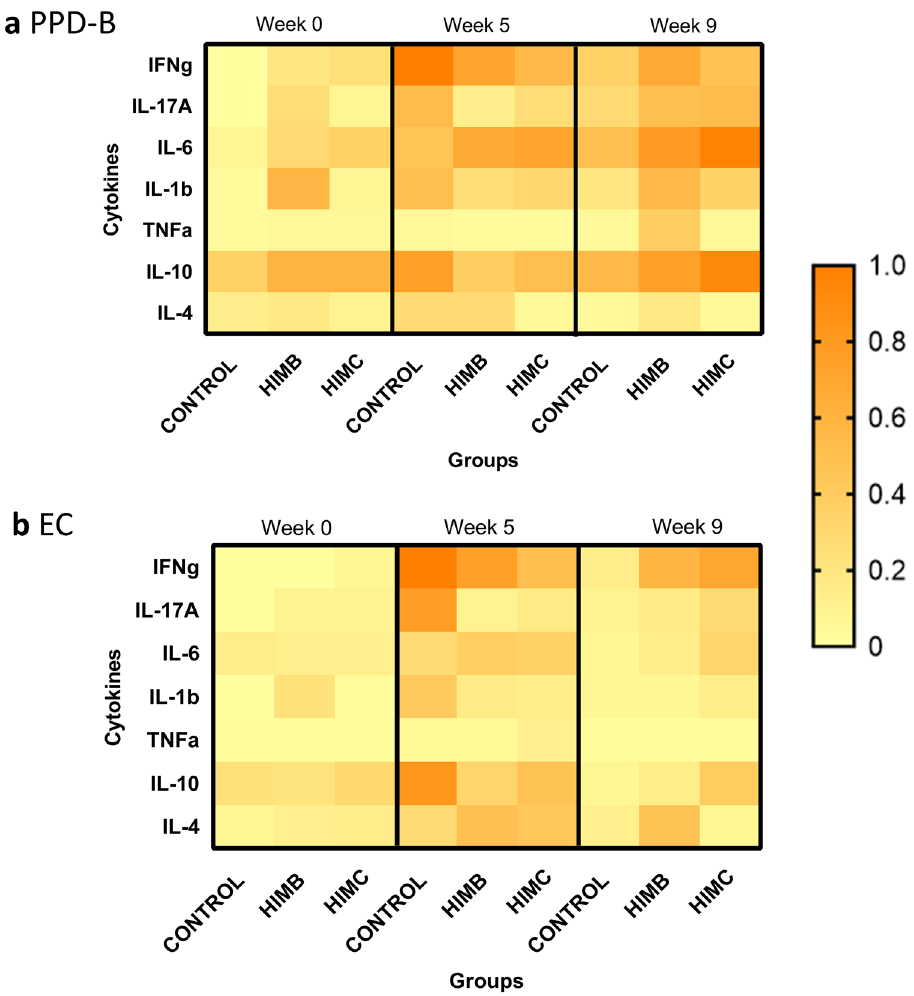
Figure 3. Cytokine profiles before and after M. caprae challenge. Cytokine productions detected in plasma after stimulating whole blood with mycobacterial antigens in each experimental group at week 0 (before challenge), and weeks 5 and 9 after challenge. ( a ) M. bovis tuberculin (PPD-B). ( b ) ESAT-6/CFP-10 antigen cocktail (E/C). The heat-map represents the mean cytokine production relative to the maximum production (100%) of each